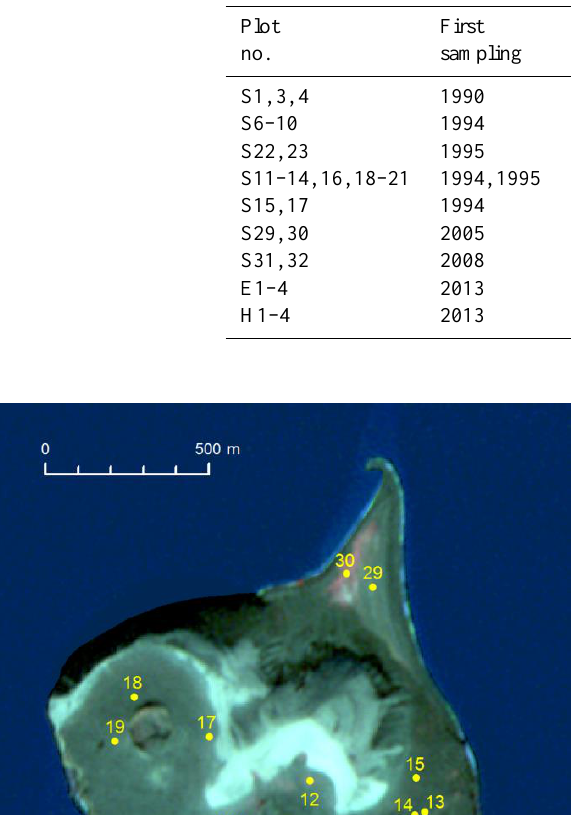
Table 1. Permanent plots on Surtsey (S) in 2012, Elliðaey (E) and Heimaey (H) in 2013, year of establishment, substrate type and influence of seabirds. The plots on Elliðaey and Heimaey have thick (>1m), developed soils on top of substrate.